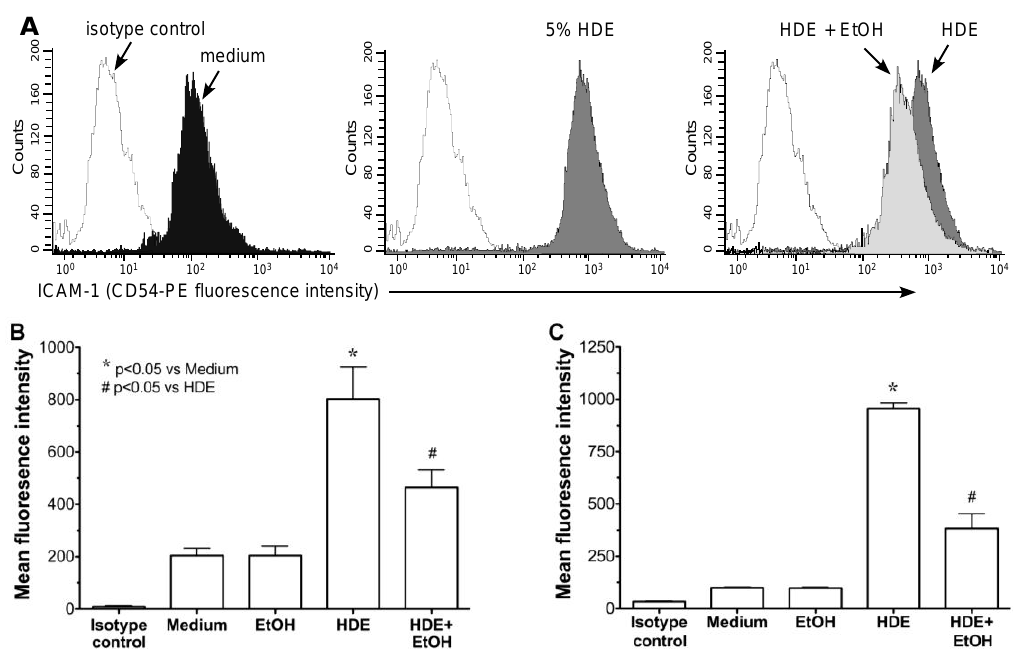
Figure 2. Alcohol pretreatment down regulates HDE-mediated ICAM-1 expression in human bronchial epithelial cells. BEAS-2B ( B ) and HBEC ( C ) were treated with control medium or 5% HDE ± 100 mM ethanol (EtOH) for 24 h and flow cytometry) analysis was performed. ( A ) Representative histogram showing significant rightward shift following HDE exposure (dark gray histogram), where open histograms represent isotype control antibody. Panel on far right depicts HDE treatment compared to EtOH + HDE treatment . Bar graphs depict means with standard error bars from N = 6 ( B ) and N = 3 ( C ) independent experiments. * p < 0.05 vs. control medium, # p < 0.05 vs. HDE.